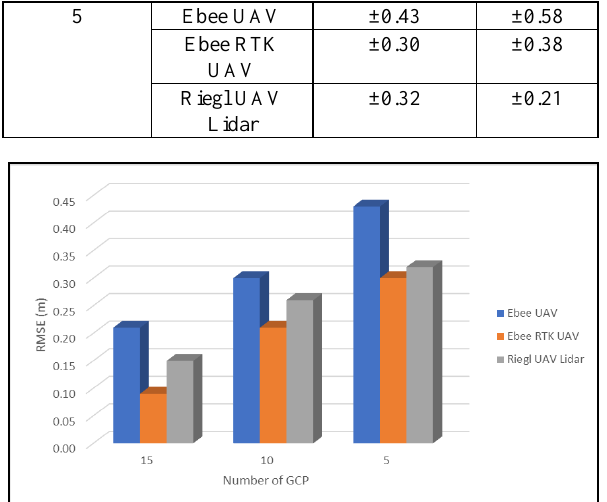
Figure 8. Graph shows the relationship between number of GCP and RMSE of Planimetry